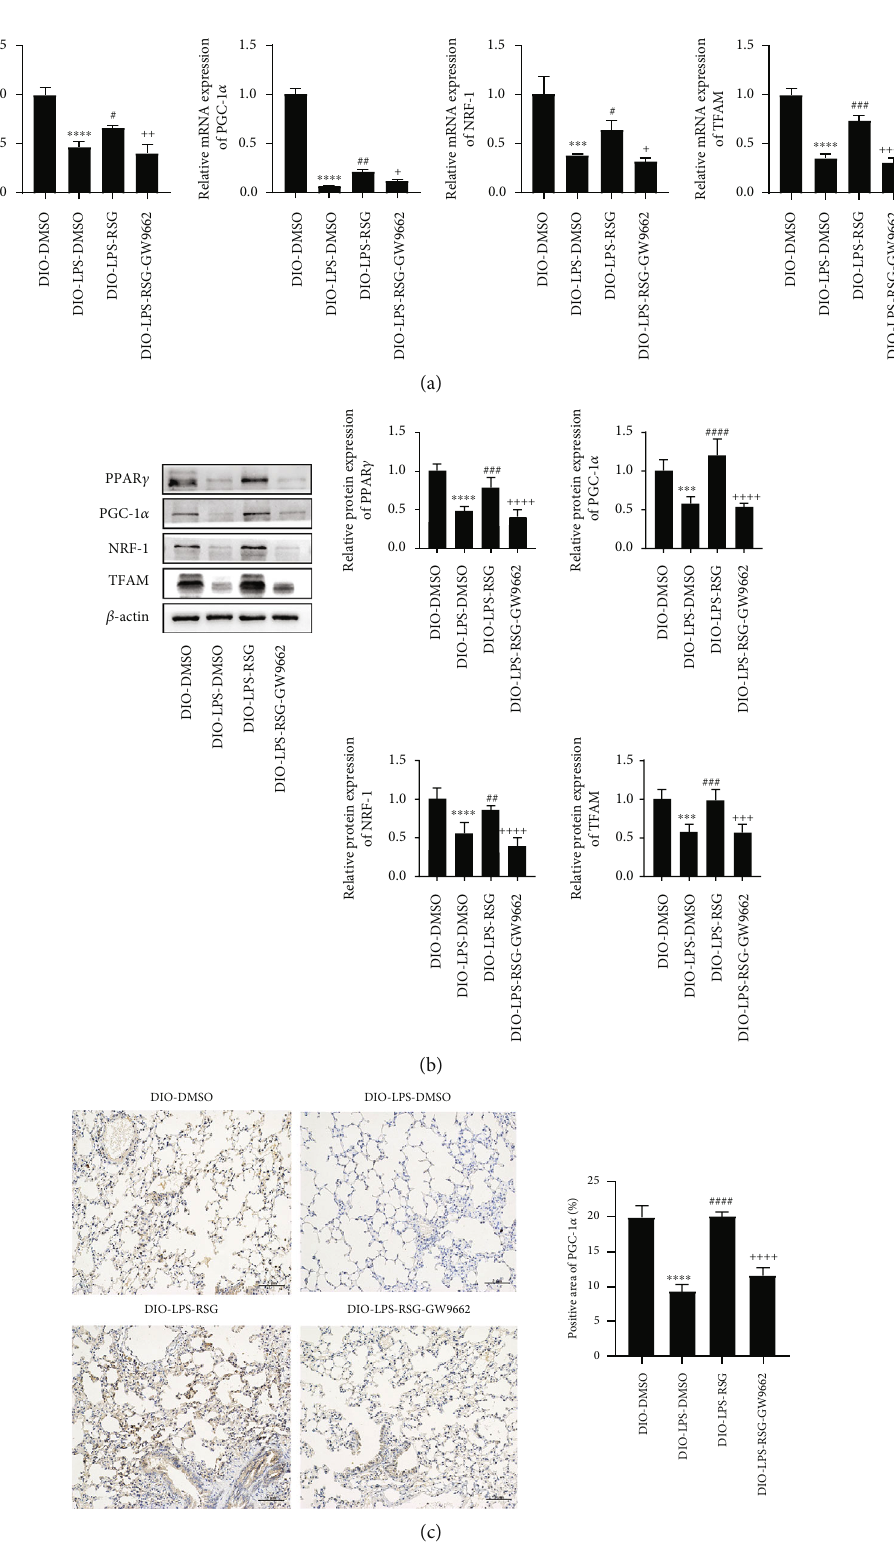
Figure 8: Activation of PPAR γ promoted mitochondrial biogenesis in lung tissue of ALI obese mice. (a) Relative mRNA expressions